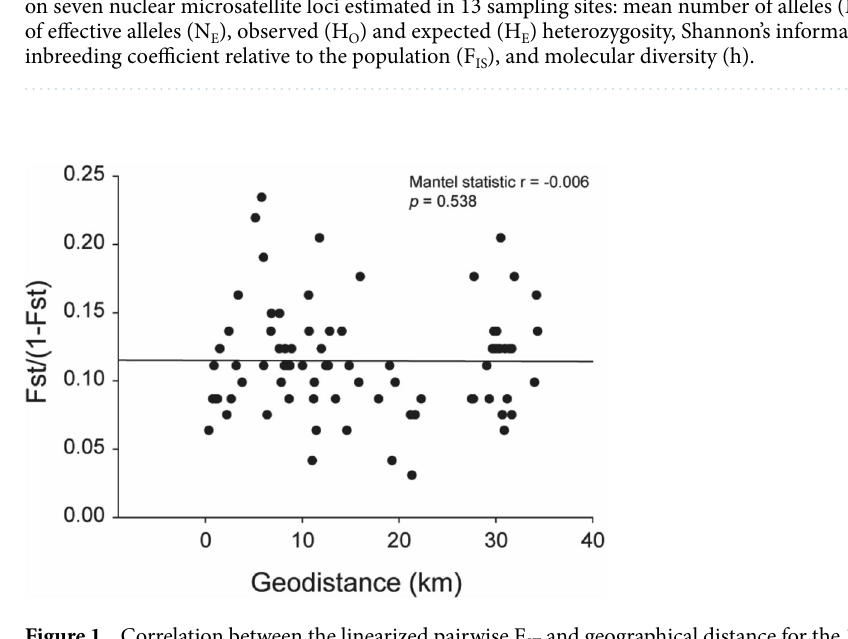
Figure 1. Correlation between the linearized pairwise F ST and geographical distance for the 13 yellow-legged hornet sampling sites in Mt. Jiri. The Mantel test revealed no significant genetic isolation based on geographical distances among 13 sampling